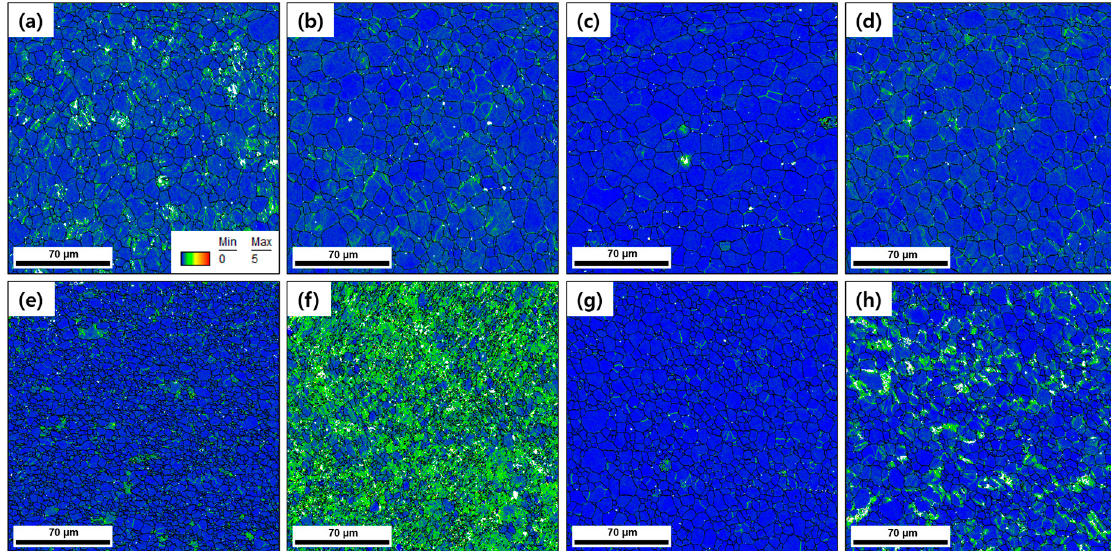
Figure 7. The KAM maps for the AR samples ( a ) annealed for 5 min at 873 K, ( b ) annealed for 5 min at 873 K and then aged at 523 K for 16 h, ( c ) annealed for 120 min at 873 K, ( d ) annealed for 120 min at 873 K and then aged at 523 K for 16 h. The IPF maps for the HRDSR samples ( e ) annealed for 5 min at 873 K, ( f ) annealed for 5 min at 873 K and then aged at 523 K for 16 h, ( g ) annealed for 120 min at 873 K, ( h ) annealed for 120 min at 873 K and then aged at 523 K for 16 h.